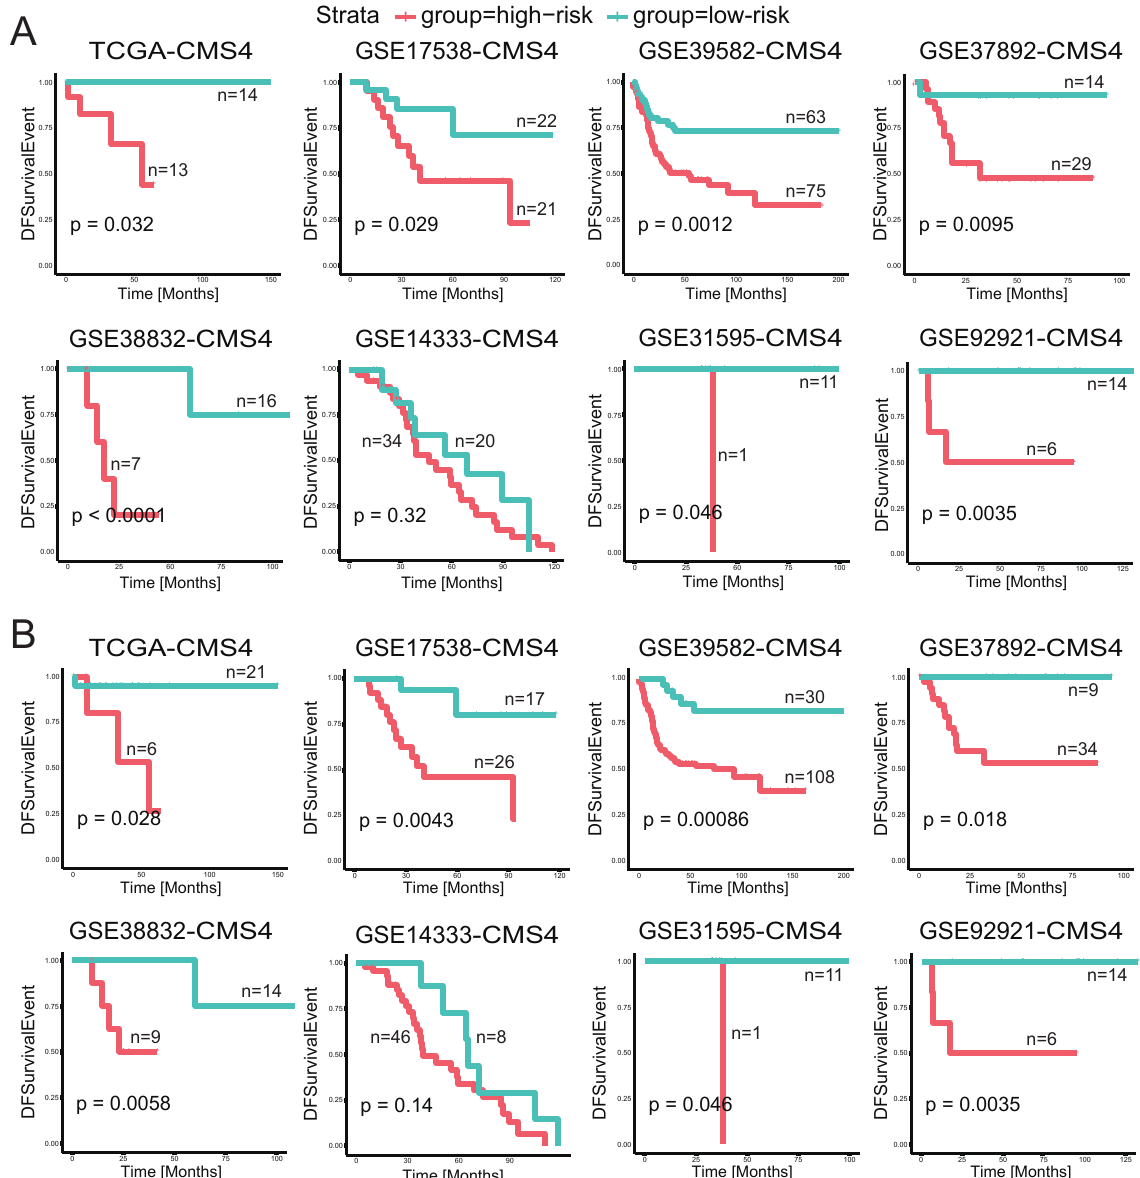
Figure 5. Evaluation of the predictive power of CUPsig and CDPsig in CMS4 subtype patients with stage II–III CRC. Kaplan–Meier survival curves of DFS in high-risk and low-risk patients with stage II–III CRC in validation datasets: ( A ) CUPsig, ( B )